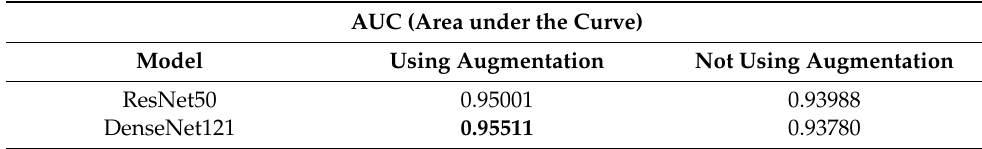
Table 1. Learning from zero with testing data set.